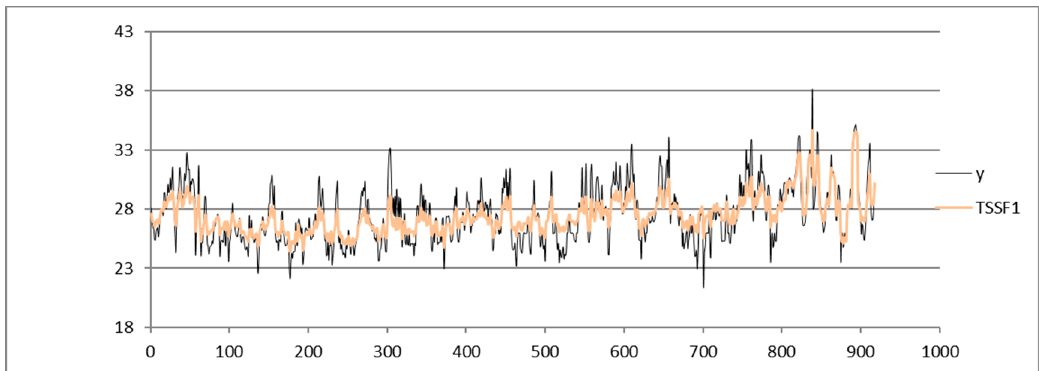
Figure 6. Plot of HI index time series from the Napoli Capodichino station dataset obtained by using the TSSF1 algorithm.